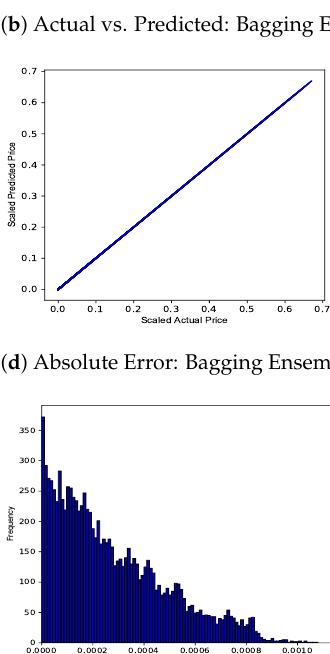
Figure 7. Actual vs. Predicted Results: Zero Collateral